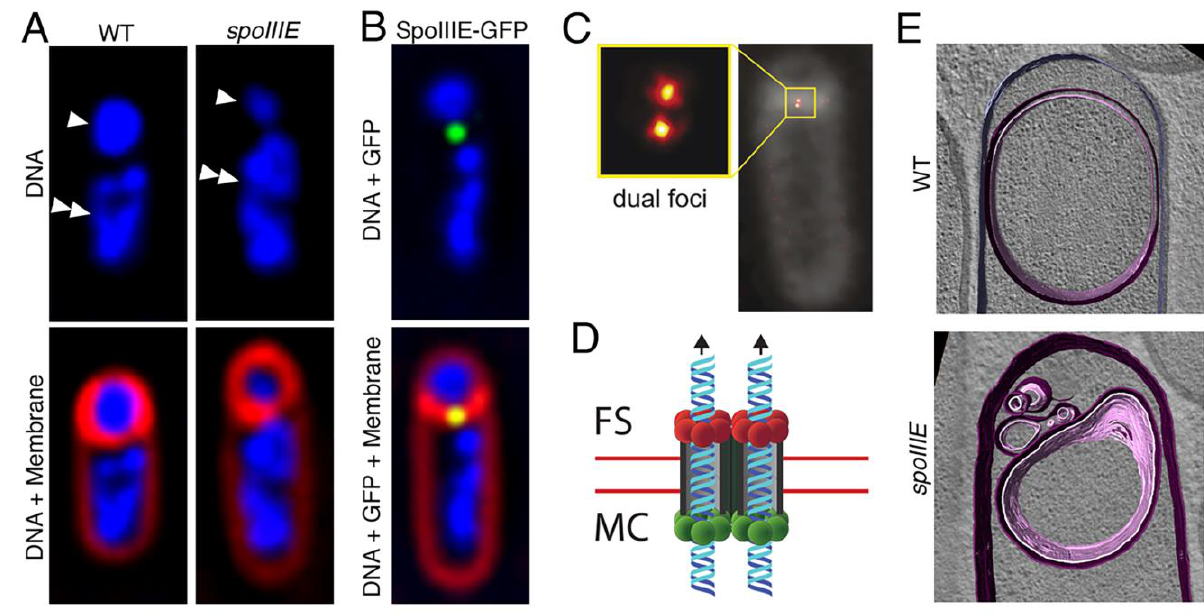
FIGURE 7: Progress in our understanding of SpoIIIE-mediated chromosome translocation. (A) Fluorescence microscopy images of a wild- type (WT, left) and of a spoIIIE mutant ( spoIIIE , right) strain of B. subtilis . The upper panels show the DNA stained with DAPI (blue), and the lower panels the overlay of DAPI-stained DNA and the membranes stained with FM 4-64 (red). In the upper panel, forespores are indicated by single arrowheads, and mother cells by double arrowheads. Wild-type forespores contain a complete chromosome. However, forespores of spoIIIE mutant strains contain only ~30% of a chromosome, and the rest remains trapped in the mother cell. (B) Fluorescence microscopy image of a sporulating cell producing a SpoIIIE-GFP fusion during chromosome translocation. The upper panel shows the DNA stained with DAPI (blue) and the GFP signal, and the lower panel shows in addition the membranes stained with FM 4-64 (red). SpoIIIE forms a focus (green) at septal midpoint, where the chromosome is trapped. (C) SpoIIIE visualized by super-resolution microscopy (PALM) in living cells with thicker polar septa. SpoIIIE forms two foci (dual foci), which are separated by a distance equivalent to the septal thickness, indicating that one cluster is present at one side of the septum and the other at the opposite side. Reproduced from [101]. (D) Model for the organiza- tion and function of the SpoIIIE translocation complex at the septal midpoint. SpoIIIE forms two side-by-side channels spanning both septal membranes (red lines), thereby allowing the simultaneous transport of both arms of the chromosome from the mother cell (MC) to the forespore (FS). Translocation is powered by SpoIIIE motor domains at the mother-cell side of the septum (green circles), which are activated to export the chromosome to the forespore. Forespore motor domains (red circles) remain inactive. (E) Cryo-electron microscopy of a wild- type sporulating cell (top), and of a spoIIIE mutant (bottom). Membranes are annotated as follows: forespore membrane, pink; mother-cell membrane, purple. Chromosome translocation is required to maintain the shape of the forespore. In the absence of chromosome transloca- tion, the forespore appears deflated. Reproduced with permission from